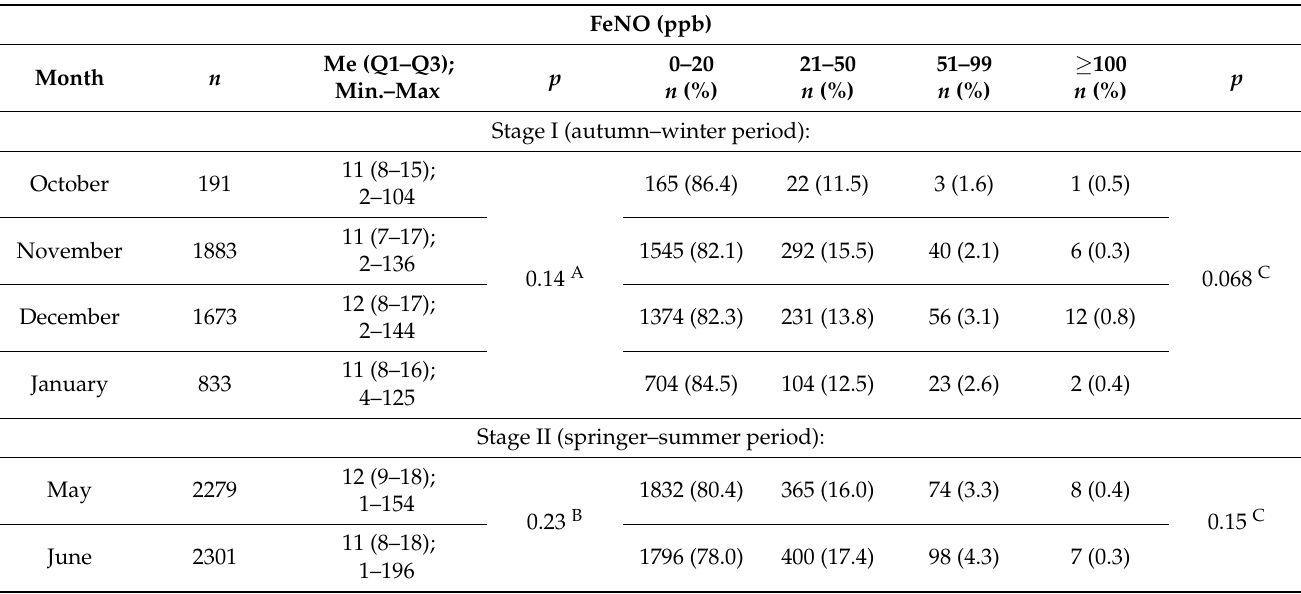
Table 1. The distribution of the measured values of FeNO. FeNO